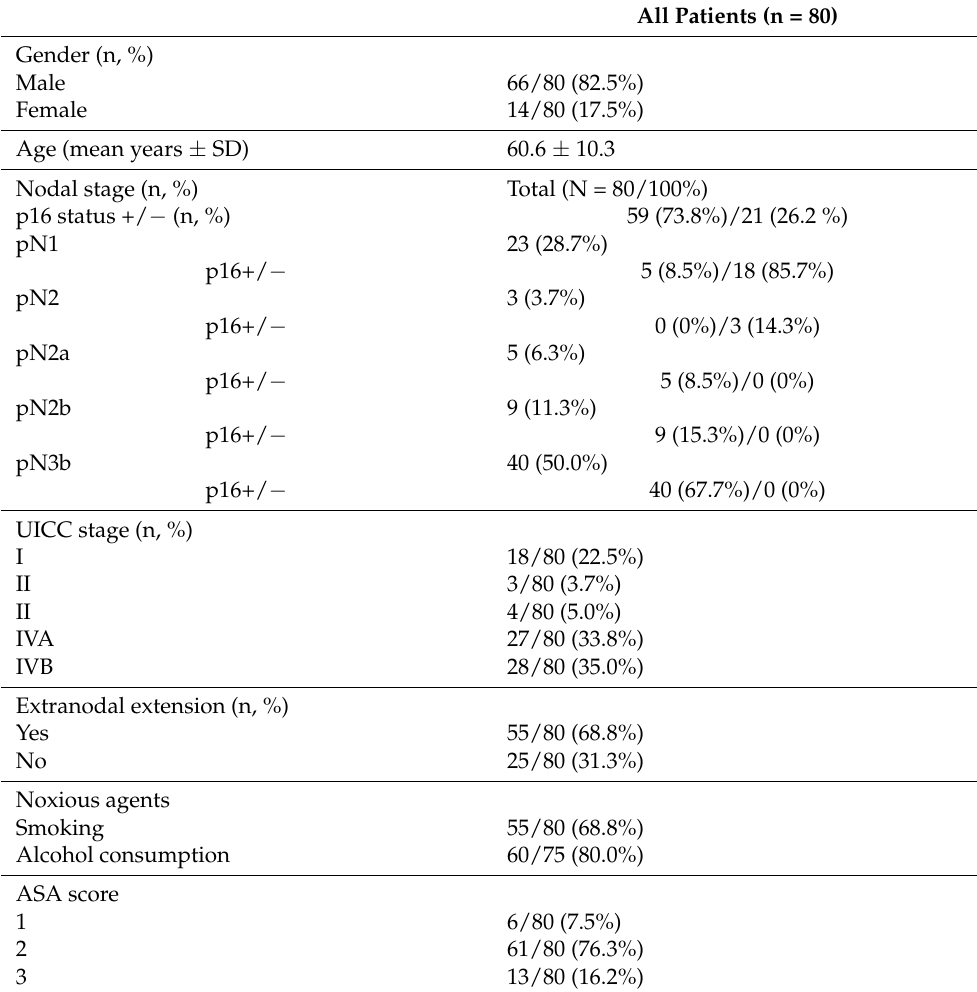
Table 1. Patient